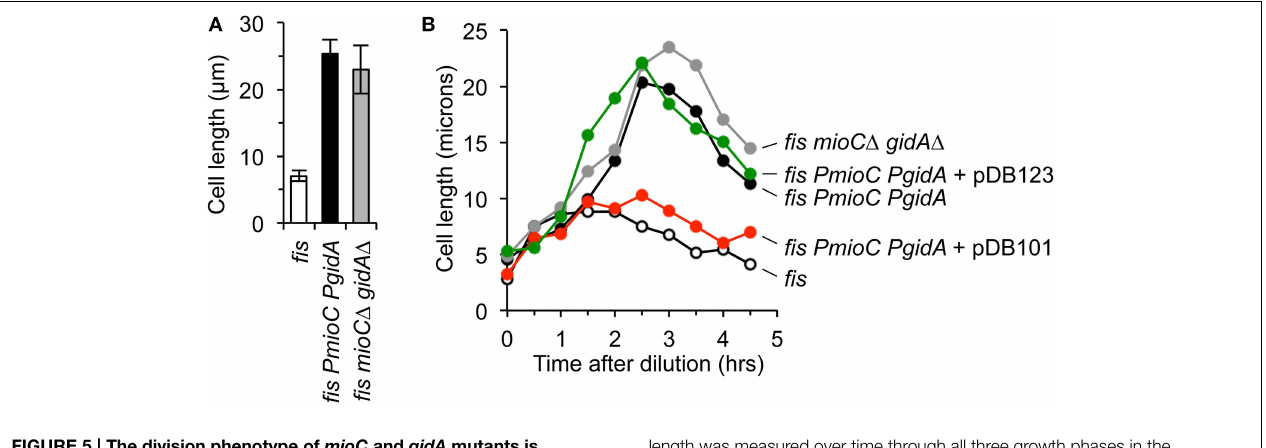
FIGURE 5 | The division phenotype of mioC and gidA mutants is complemented in trans . (A) Cell length in exponential cultures of fis parental, fis with mioC and gidA promoter mutations, and fis with mioC and gidA in-frame ORF deletions with active transcription, was measured by direct microscope observation (3 independent experiments, ± 1 SD). (B) Cell